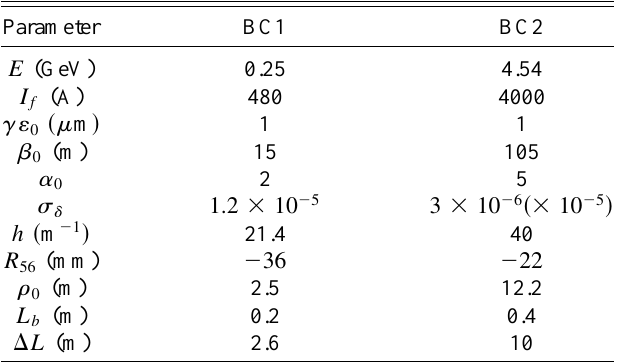
TABLE I. Basic beam and chicane parameters for the LCLS bunch compressors [12]. Parameter